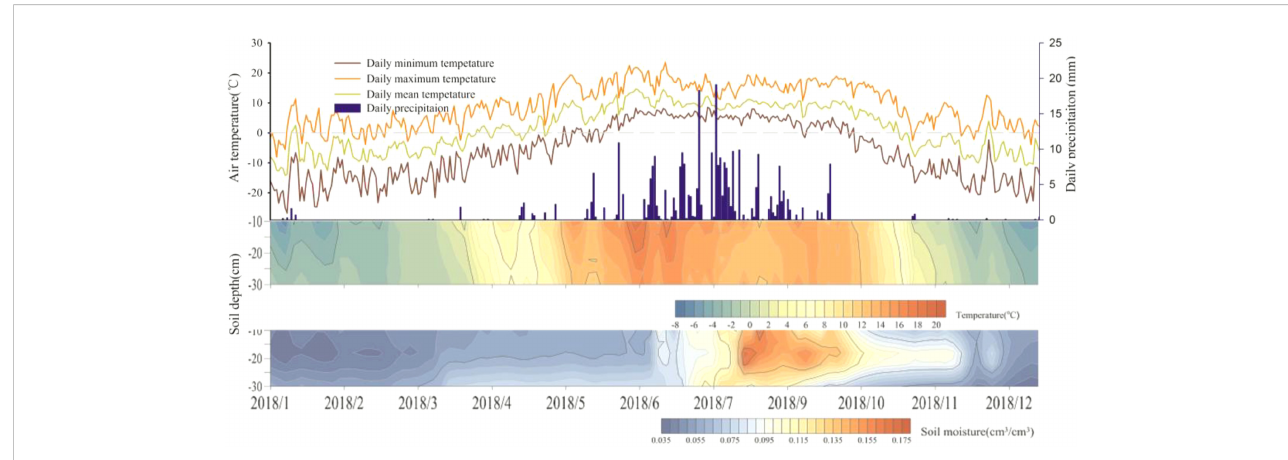
FIGURE 2 Diagram of the daily air temperature (mean, minimum and maximum), precipitation and soil temperature and soil moisture (10 cm, 20 cm and 30